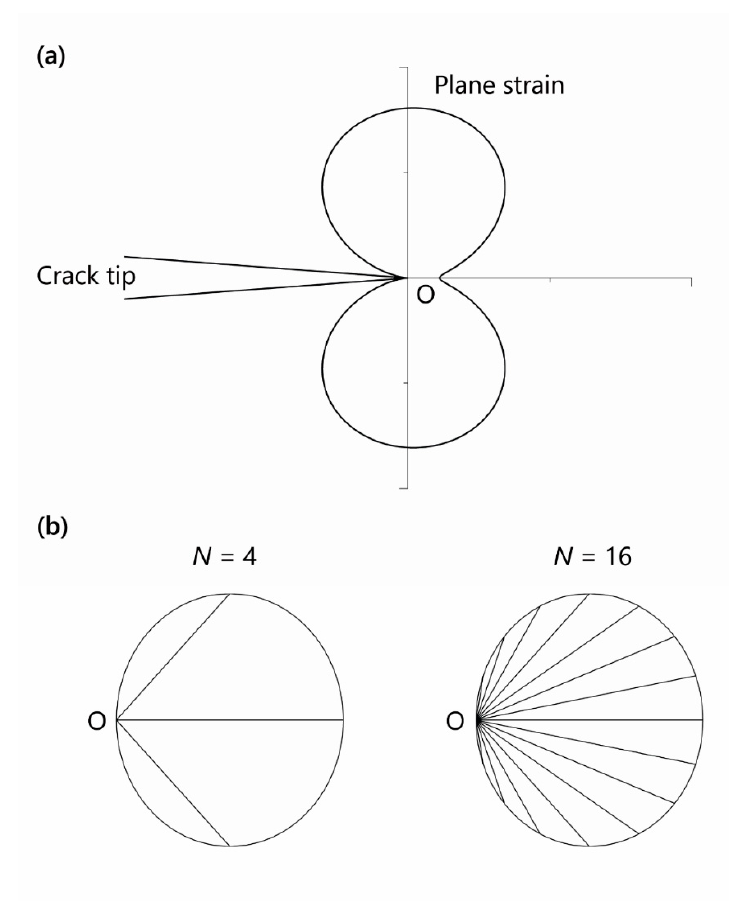
Figure 6. ( a ) Plastic zone shapes in Mode I according to Von Mises yield criteria. The boundary of the plastic zone is plotted non-dimensionally according to Equation (1). O is the location where the crack tip is about to propagate. ( b ) Schematic explanation of the geometric number N . The individual chord length of a 2D-intersection of a 3D- α ellipsoid is denoted by L and the average chord length by L , respectively. N − 1 chords cut the intersection equally. The schemata have a superposition nature and combine the possible pathways of the crack. High symmetry generally diminishes N and enlarges L . According to Equation (7), K IC , N = 4 > K IC , N = 16 Combining Equations (3) and (6) yields